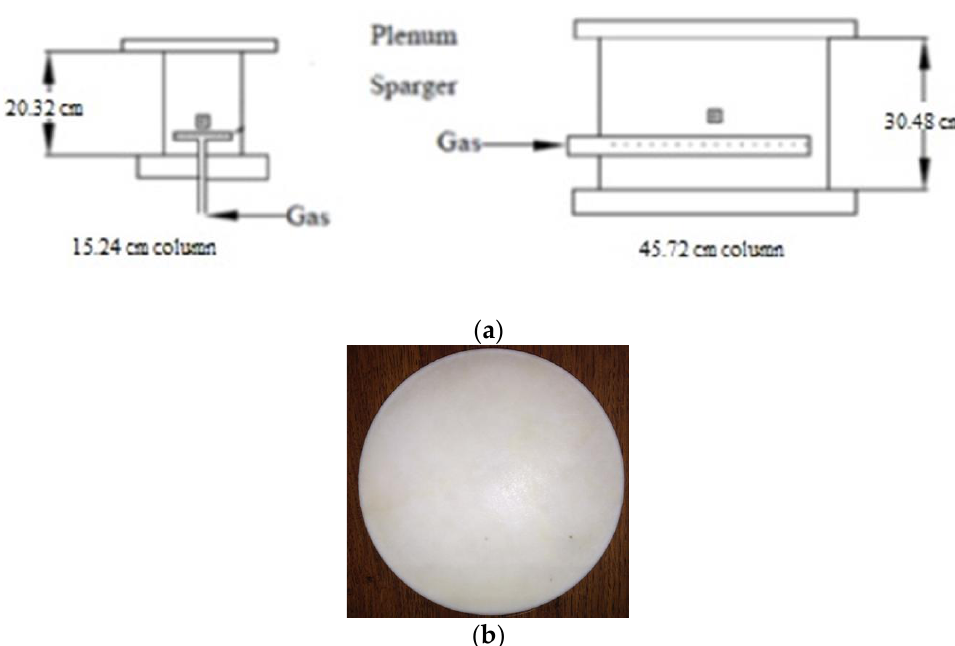
Figure 2. ( a ) plenum design ( b ) Distributor for 0.14 m and 0.44 m fluidized bds made of a porous Polyethylene sheet with a pore Size of 15 – 40 μm.